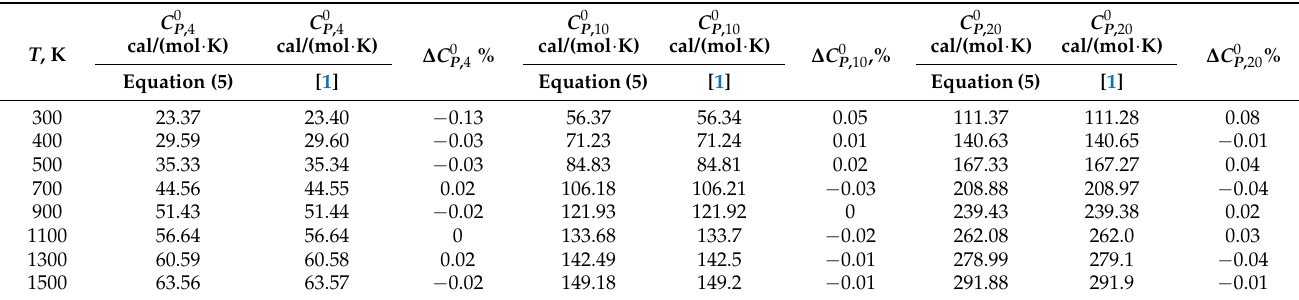
( T ) of n -C 4 H 10 , n -C 10 H 22 , n -C 20 H 42 . P